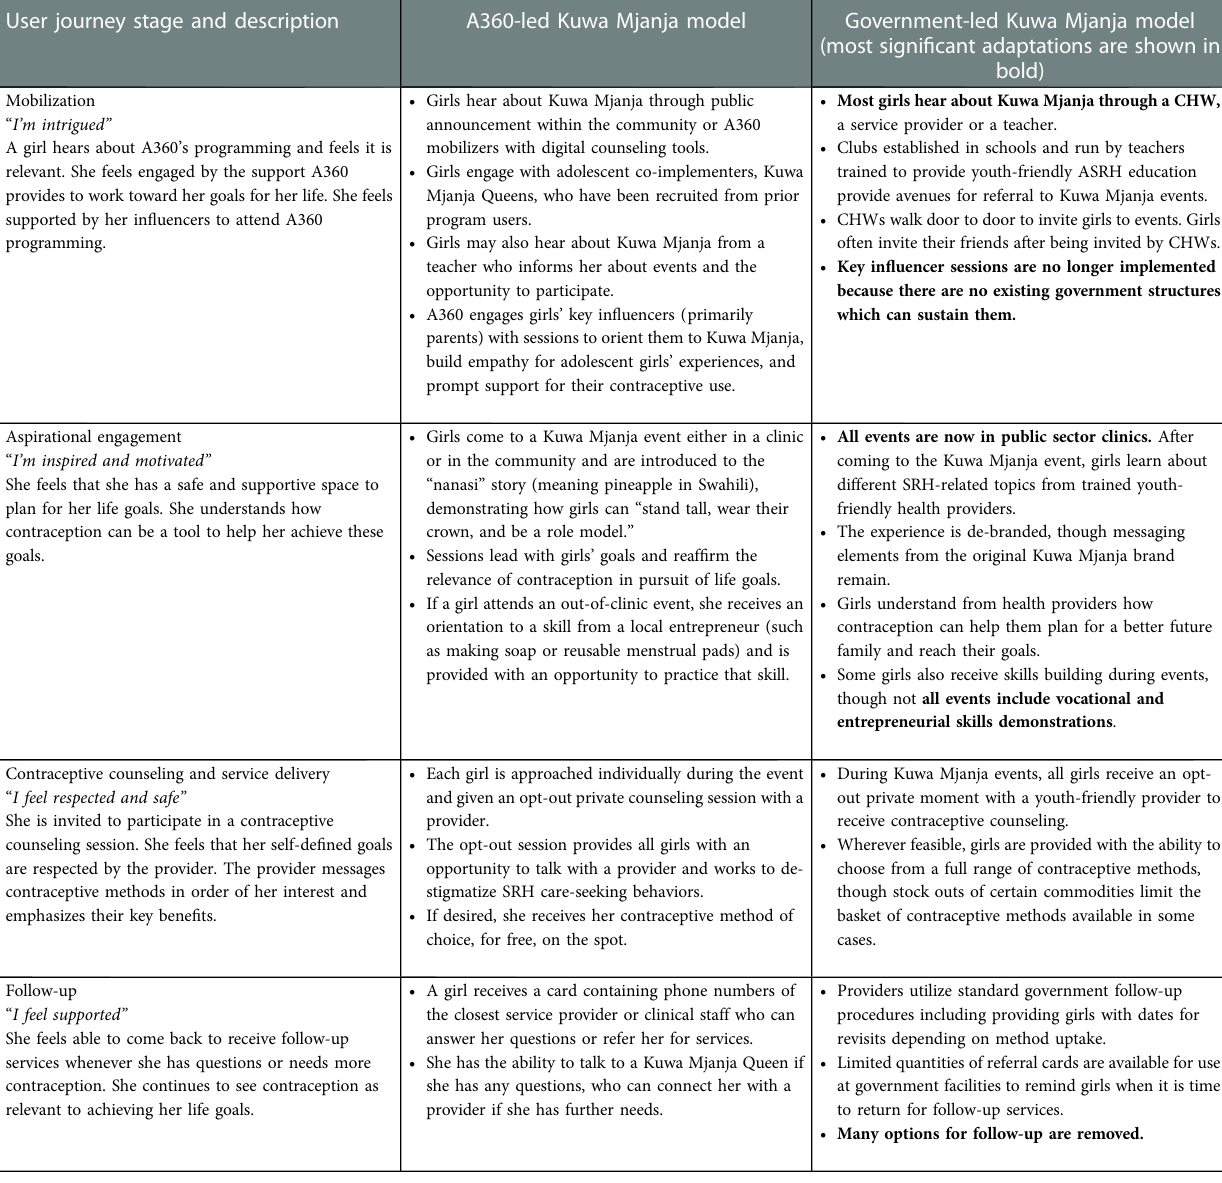
TABLE 1 Government-led Kuwa Mjanja user journey compared to A360-led user journey. User journey stage and